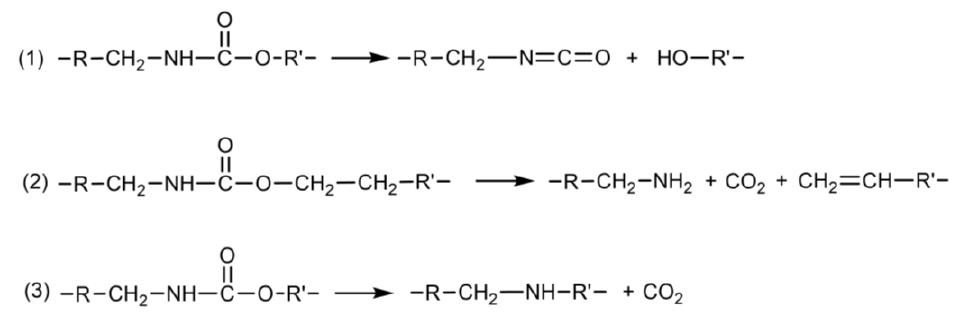
Figure 12. Three possible degradation pathways of TPU under high-temperature treatment.